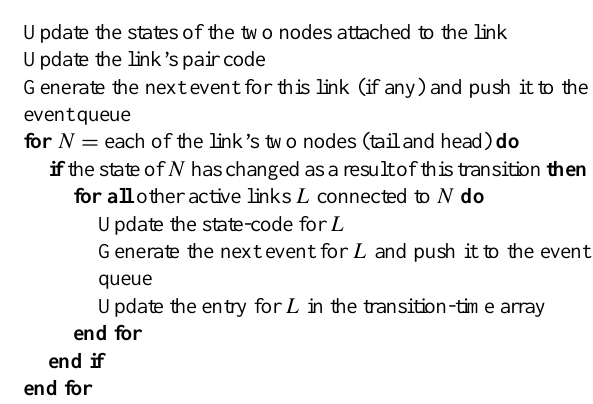
Algorithm 2 Processing a transition